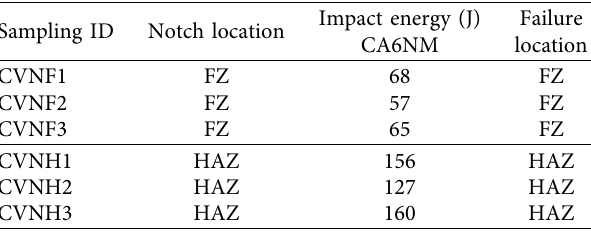
Table 6: Charpy V-notch impact properties in FZ and HAZ of PWHTed EB welds tested at − 18 ° C.